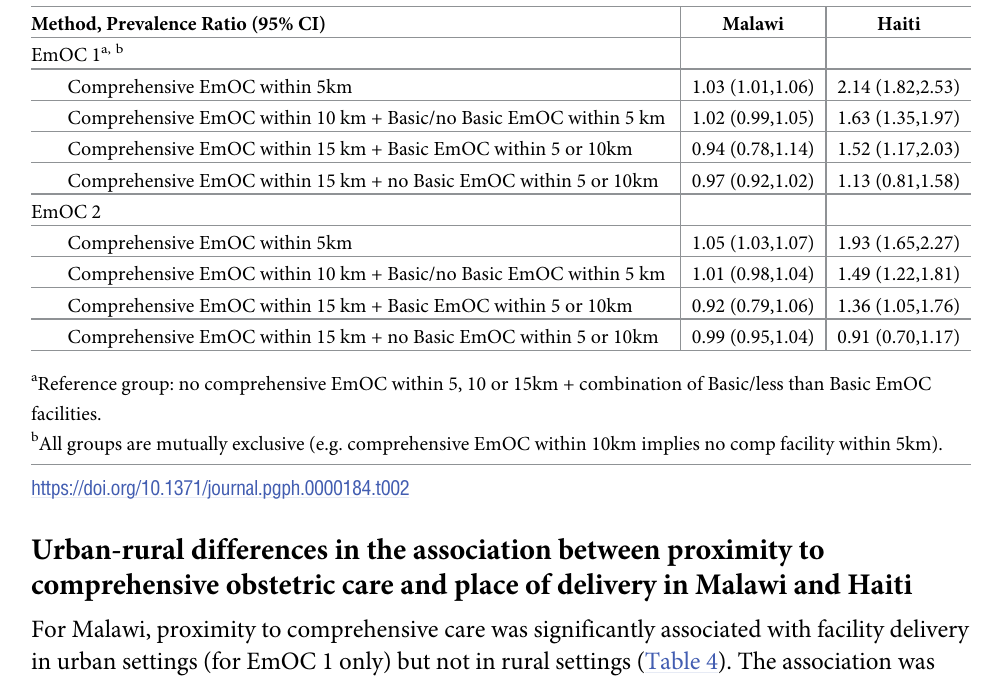
Table 2. Crude association between proximity to obstetric care on facility delivery among women residing in Malawi and Haiti using two EmOC assessment methods: Demographic Health Surveys and Service Provision Assessments 2014–2018.